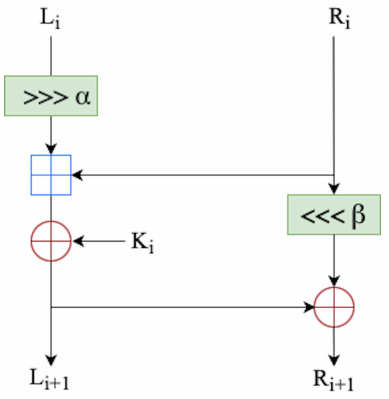
Figure A1. Speck round